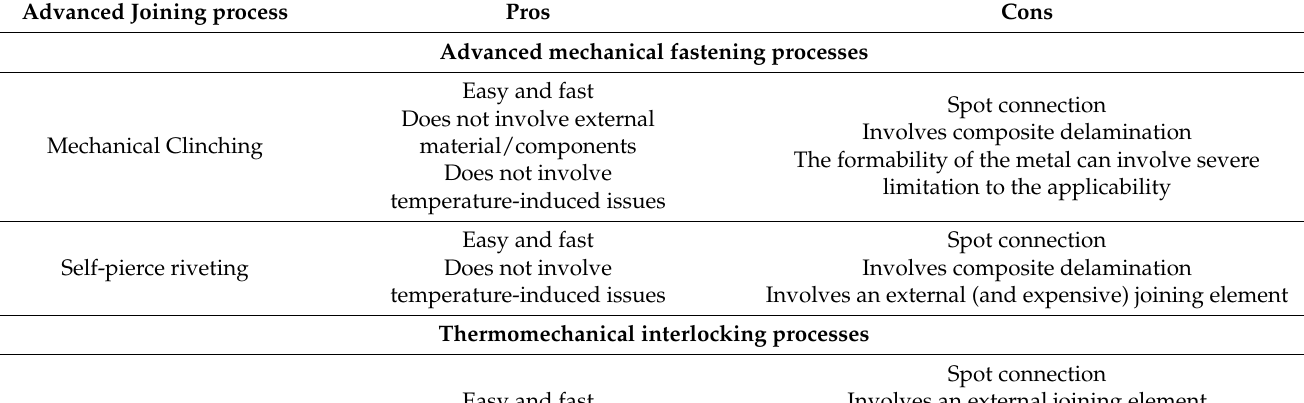
Table 4. Main pros and cons of the advanced joining processes for metal-composite hybrid